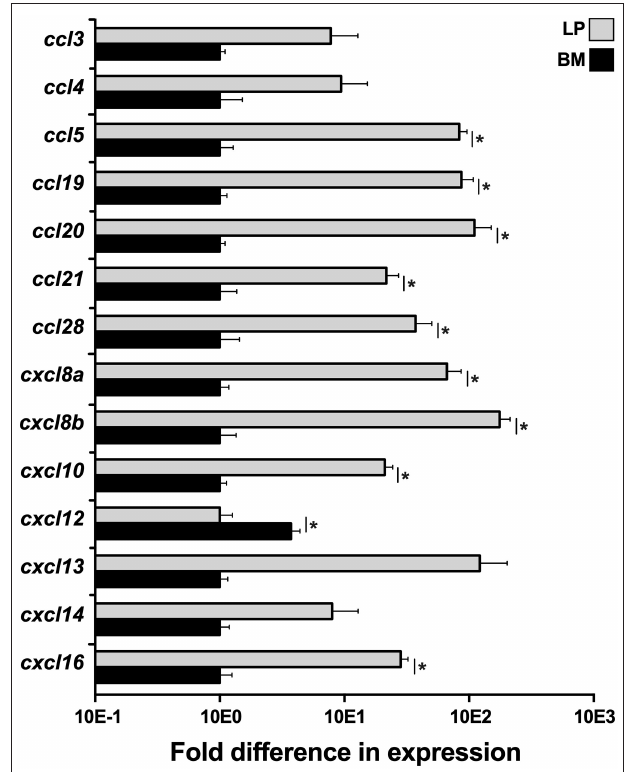
FIGURE 4 | Analysis of chemokine gene expression in X. laevis liver periphery and bone marrow. Frog liver periphery (LP) and bone marrow (BM) from five individual animals ( N = 5) were examined for their expression of a panel of chemokine genes by qPCR. All gene expressions were quantified relative to the gapdh endogenous control and normalized against the lowest observed expression. Results are means ± SEM and (*) overhead of horizontal lines denote statistical significance, P <